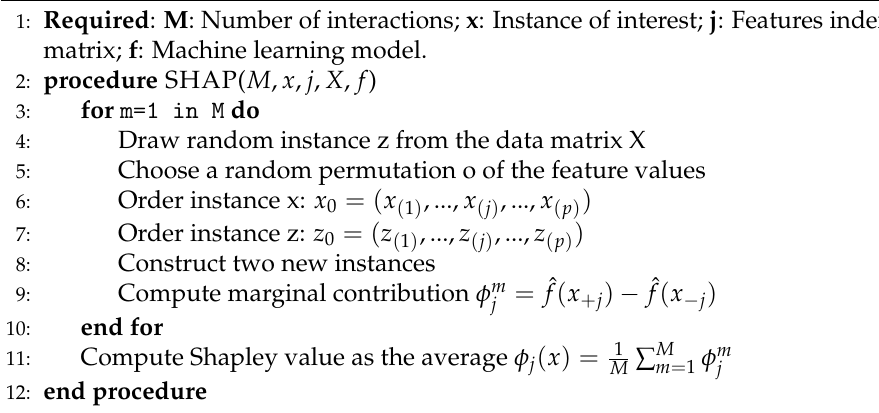
Algorithm 1 SHAP basic